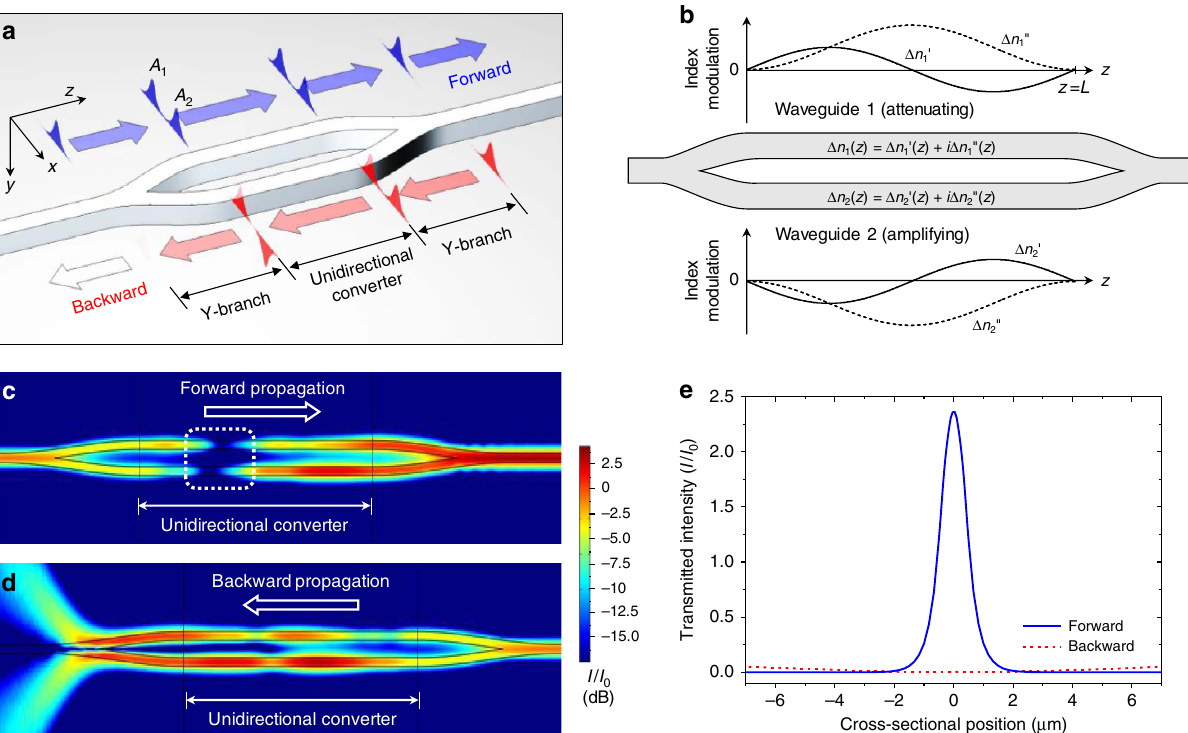
Figure 1 | On-chip optical nonreciprocity based on nonlinear dynamics near an exceptional point. ( a ) Basic operating scheme of the proposed concept. ( b ) Effective index modulation profiles over the unidirectional converter region for the attenuating (upper) and amplifying (lower) waveguides. ( c , d ) Two- dimensional numerical calculations (FEM, Comsol Multiphysics) assuming single-mode slab waveguides with the following optical parameters: cladding index of 1.50; core index of 1.55; core index modulation depth D n core ¼ 6 (cid:3) 10 (cid:2) 4 . The effective index modulation amplitude is given by D n 0 ¼ G D n core and the confinement factor is G ¼ 0.71. Operation at the vacuum wavelength of 1,130nm and in the fundamental transverse-electric mode (TE 0 ) is assumed. The colour scale indicates intensity I in dB with respect to the incident intensity I 0 . The peak intensity of the incident mode is I 0 ¼ I S for both the forward and backward transmission cases, where I S denotes a gain saturation intensity constant. ( e ) Cross-sectional profiles of the transmitted intensity in the forward and backward directions. The estimated nonreciprocal transmission ratio (NTR) is 28.7dB and the forward transmission gain is